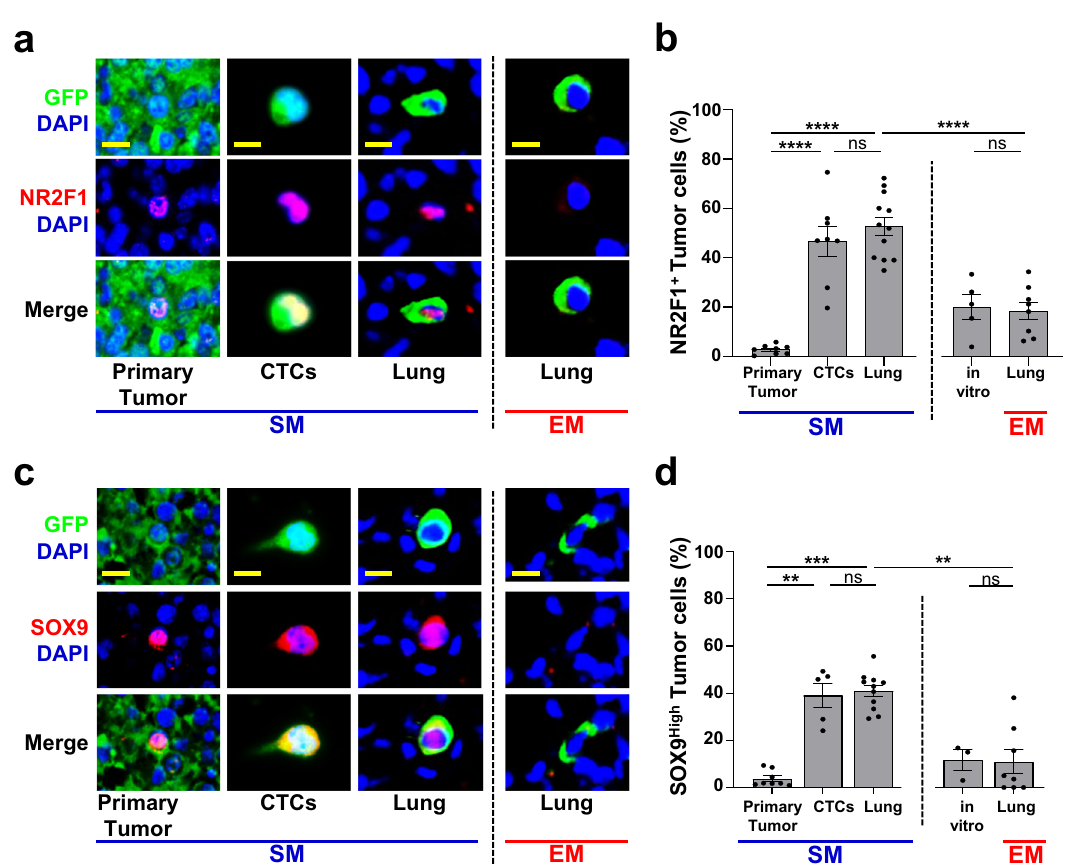
Fig. 4 Spontaneously metastasizing tumor cells are more frequently positive for dormancy or stem-like markers compared to intravenously injected tumor cells. a Representative immuno fl uorescence images of NR2F1 expression in primary tumors, circulating tumor cells (CTCs), and disseminated tumor cells (Lung) from an E0771-GFP SM model (Left) and in disseminated tumor cells (Lung) from an EM model (right). Green = GFP, Red = NR2F1, Blue = DAPI. Scale bar for Primary Tumor = 50 μ m. Scale bar for CTCs and Lung = 15 μ m. b Percentage of NR2F1-positive and negative tumor cells cells in 12 animals; EM Lung: n = 199 cells in 8 animals. In vitro: n = 463 cells in 5 independent experiments. Bar = mean. Error bars = ±SEM. For